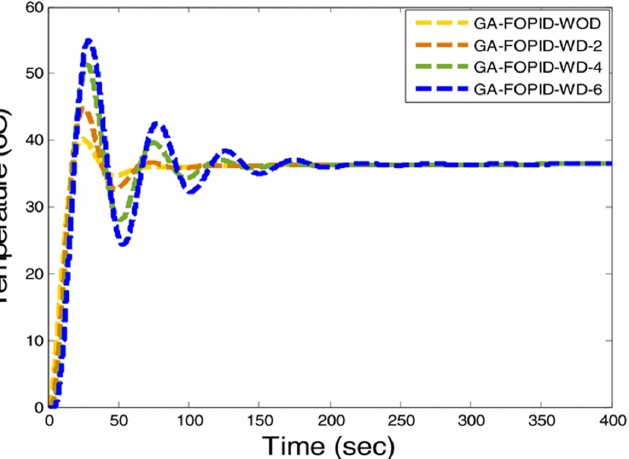
Figure 15. Ambulance output plot comparison with fractional-order PID, along with GA .